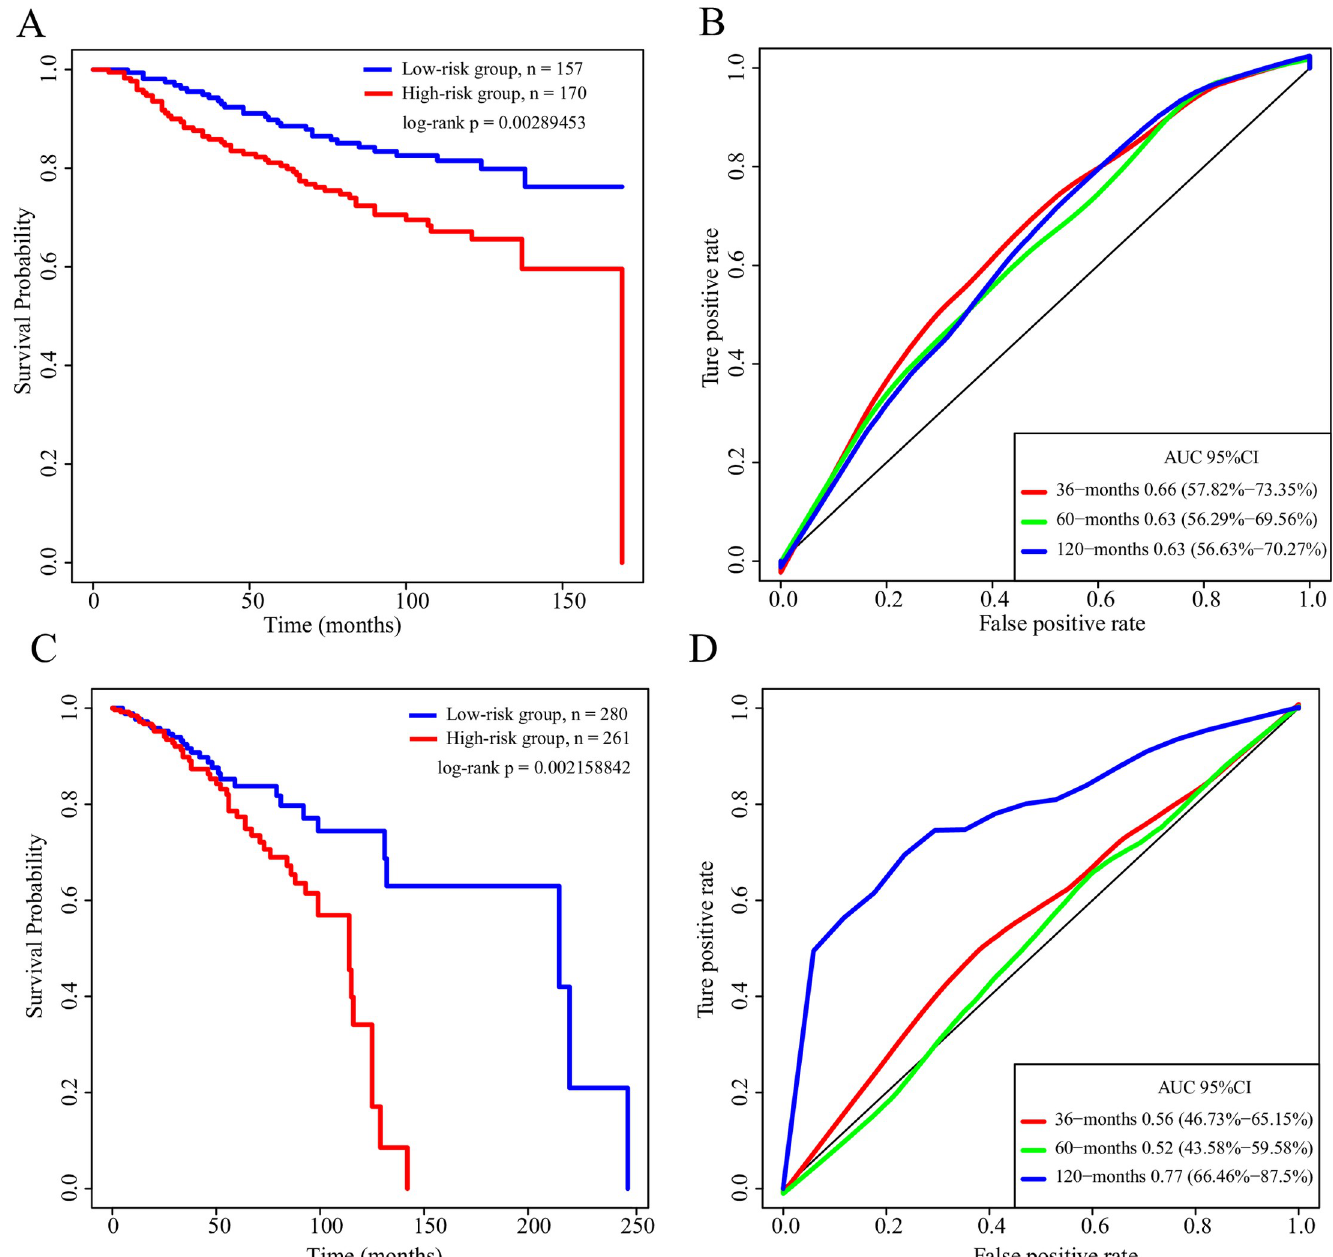
Fig 4. A: KM survival curve of the distribution of the 6-gene signature in the TCGA test set. B: The ROC curve and AUC of the 6-gene signature classification in the TCGA test set. C: KM survival curve distribution of the 6-gene signature in GSE20685 dataset. D: The ROC curve and AUC of the 6-gene signature classification in GSE20685